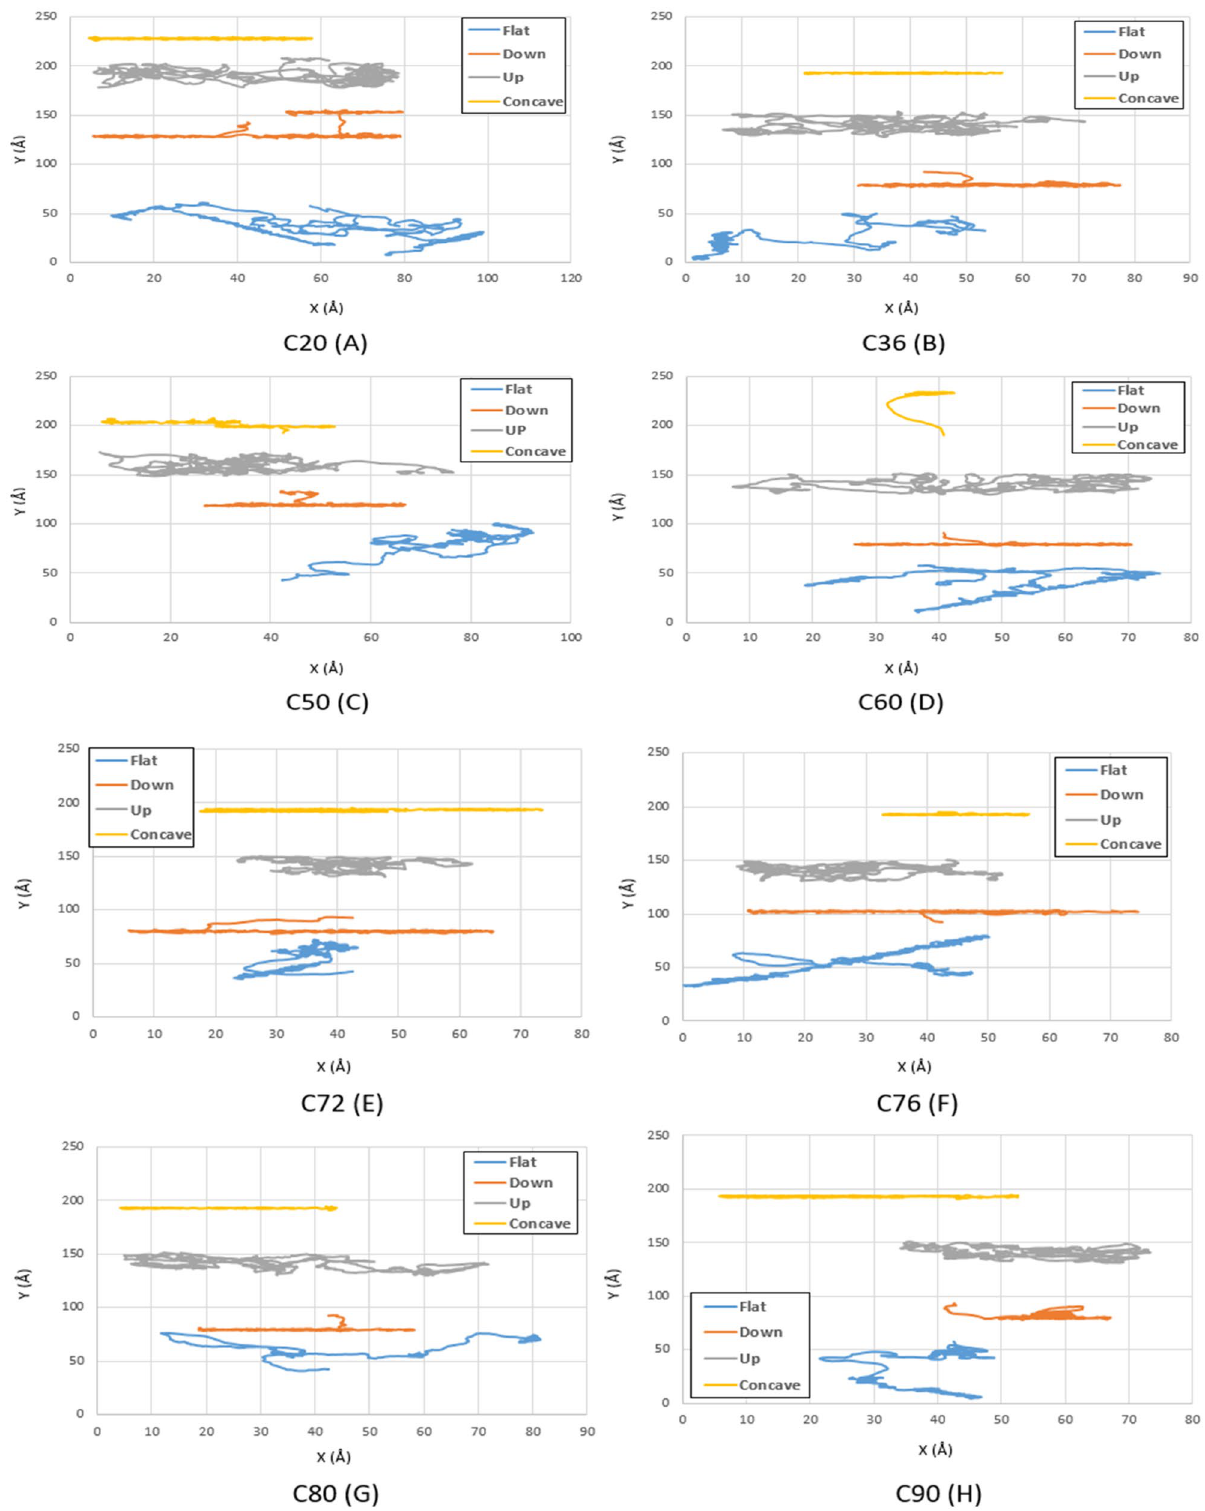
Figure 6. Trajectories of different fullerenes on a gold substrate at 400K for C 20 ( A ), C 36 ( B ), C 50 ( C ), C 60 ( D ), C 72 ( E ), C 76 ( F ), C 80 ( G ), and C 90 ( H ). The blue, red, black and yellow lines show the trajectories of the molecules on the flat, down side of the step, top side of the step, and concave substrates,